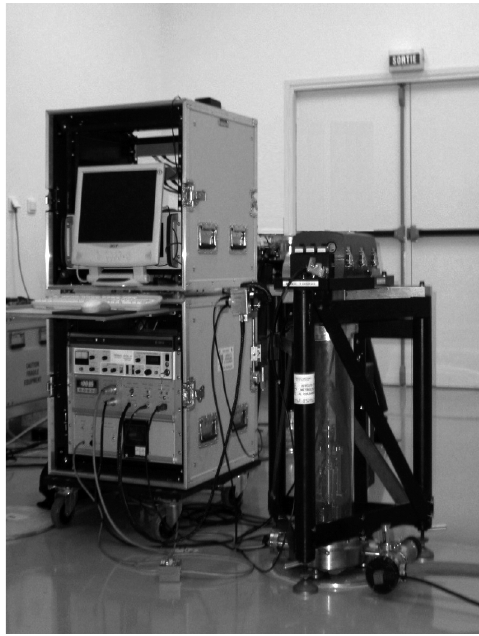
Fig. 2. Picture of the new absolute gravimeter